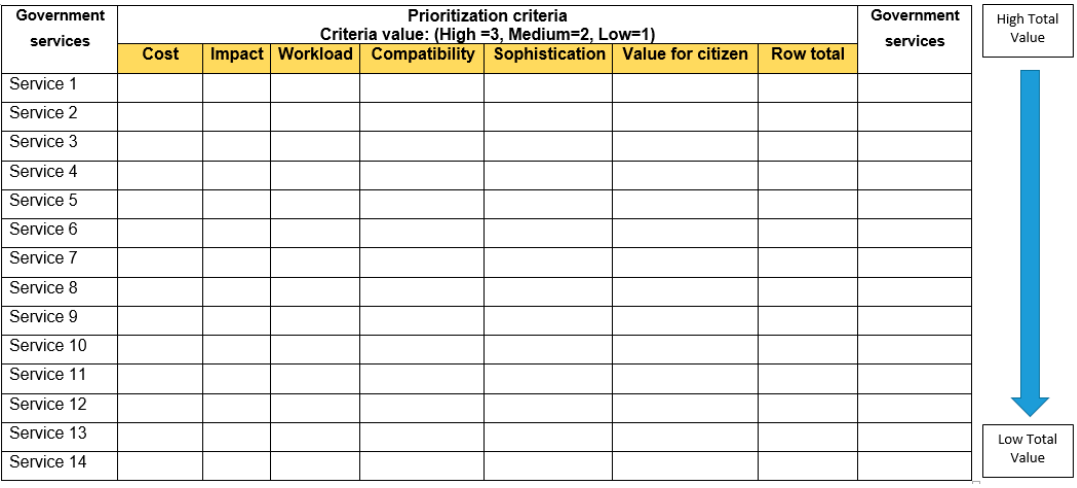
Figure 4. Service prioritization template.